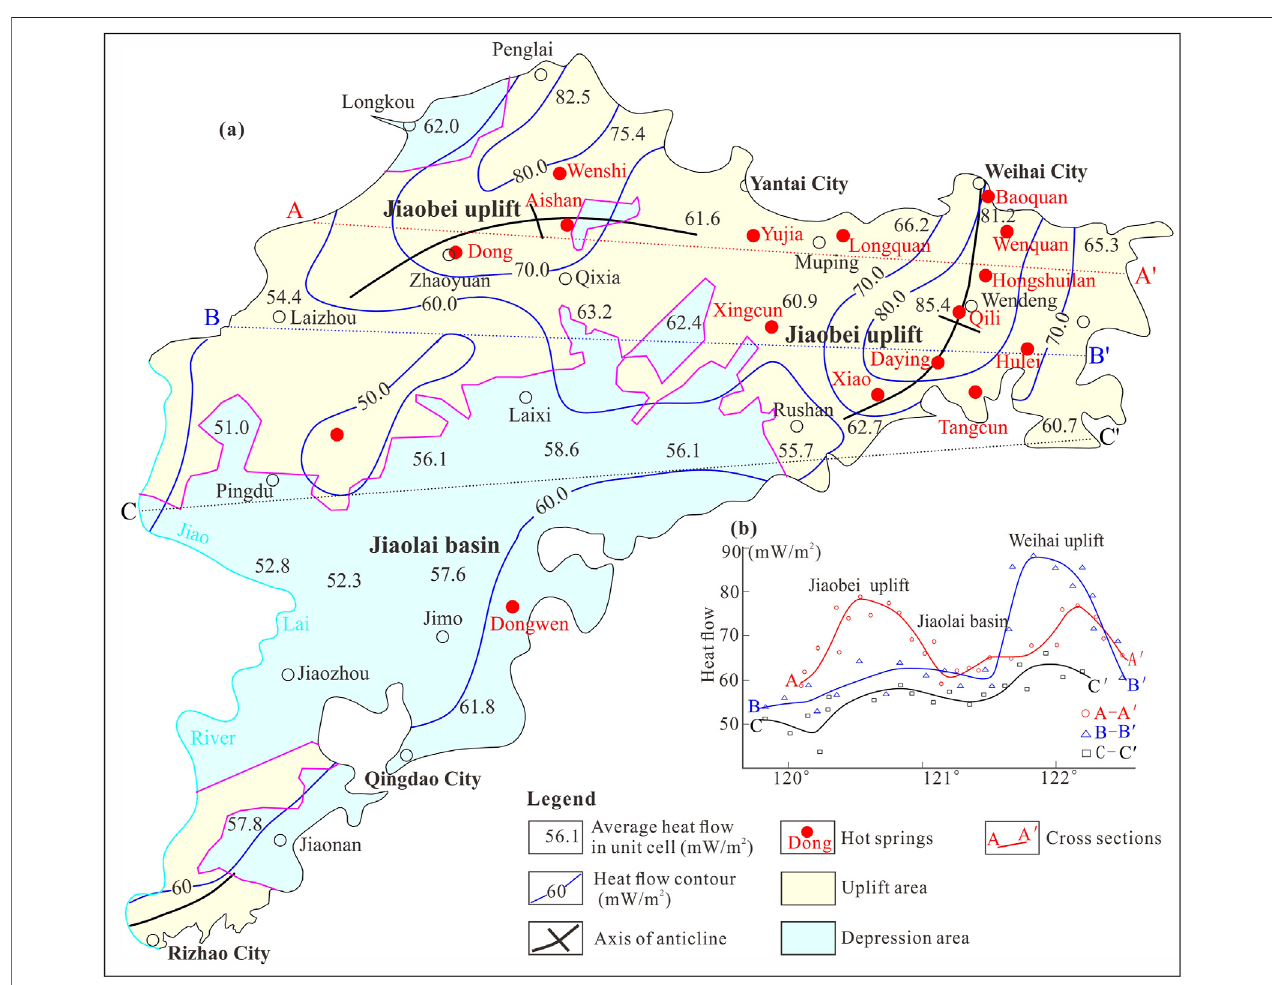
FIGURE 3 | Terrestrial heat fl ow contours (A) and pro fi les (B) in the Jiaodong Peninsula based on silica temperatures (modi fi ed from Li et al., 1997).